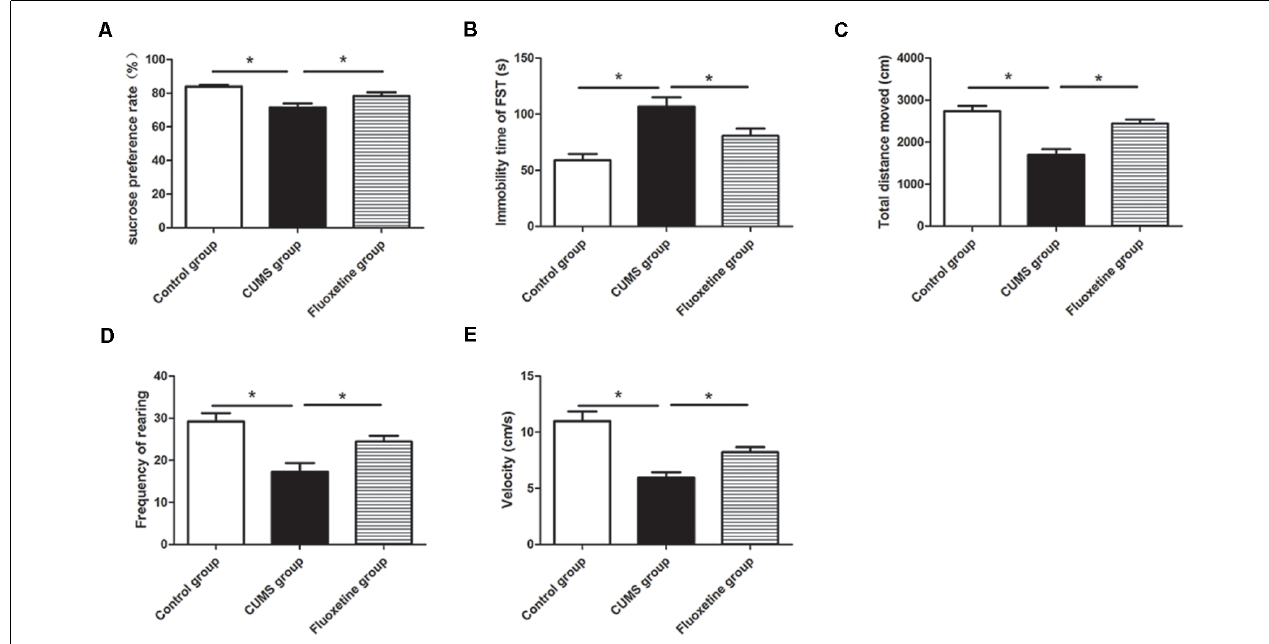
FIGURE 2 | Effect of chronic unpredictable mild stress (CUMS) and fluoxetine treatment on depressive-like behaviors: sucrose preference rate in the sucrose preference test (SPT; A ), immobility time in the FST (B) , total distance traveled (C) , rearing frequency (D) , and velocity (E) in the open field test (OFT). * P < 0.05.